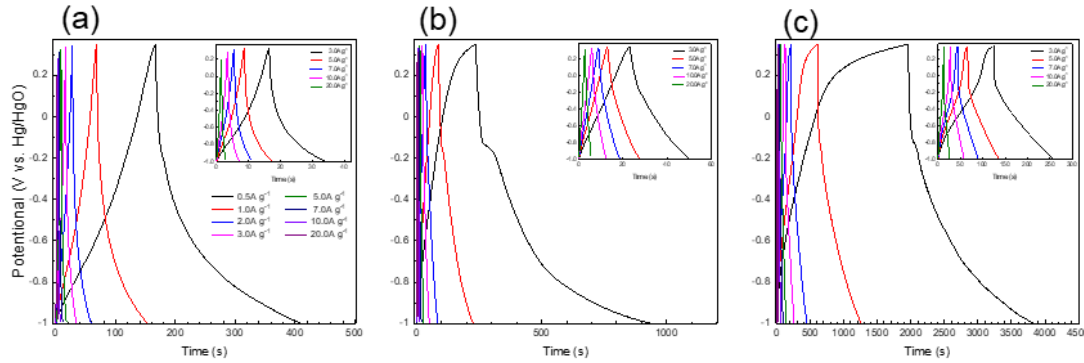
Figure 9. Specific capacitances of carbon/DDSQ hybrids derived from ( a ) pure phenolic, ( b ) PDDSQ ‐ 50, and ( c ) pure PDDSQ, measured at various current densities.